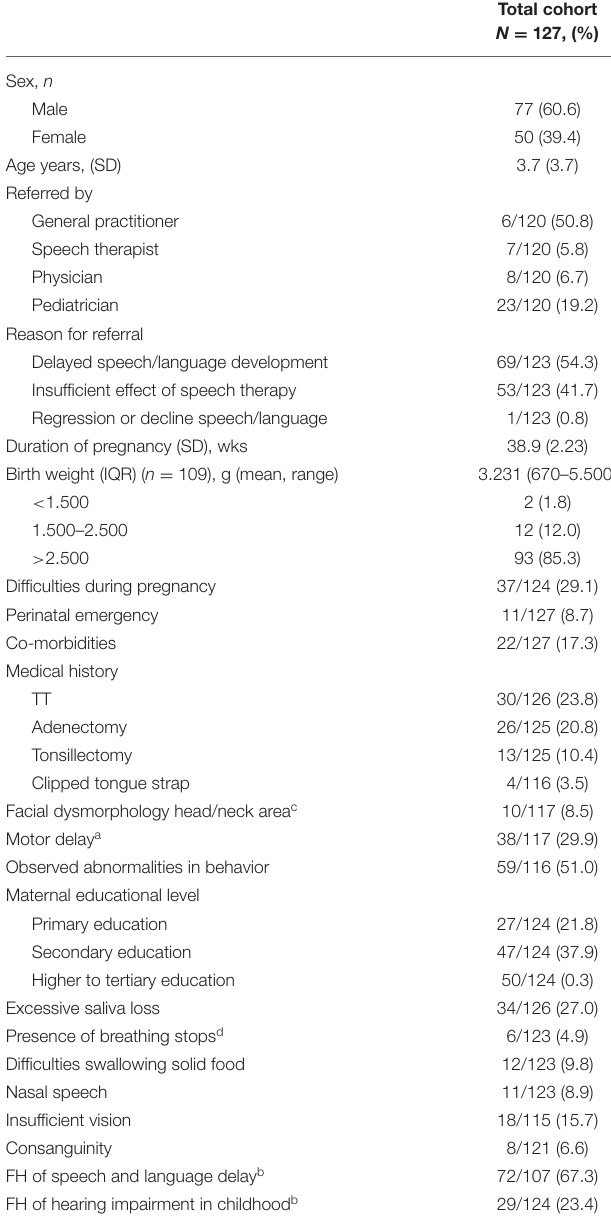
TABLE 1 | Overview of patients diagnosed with developmental language disorder (DLD) who were additionally assessed by a geneticist.